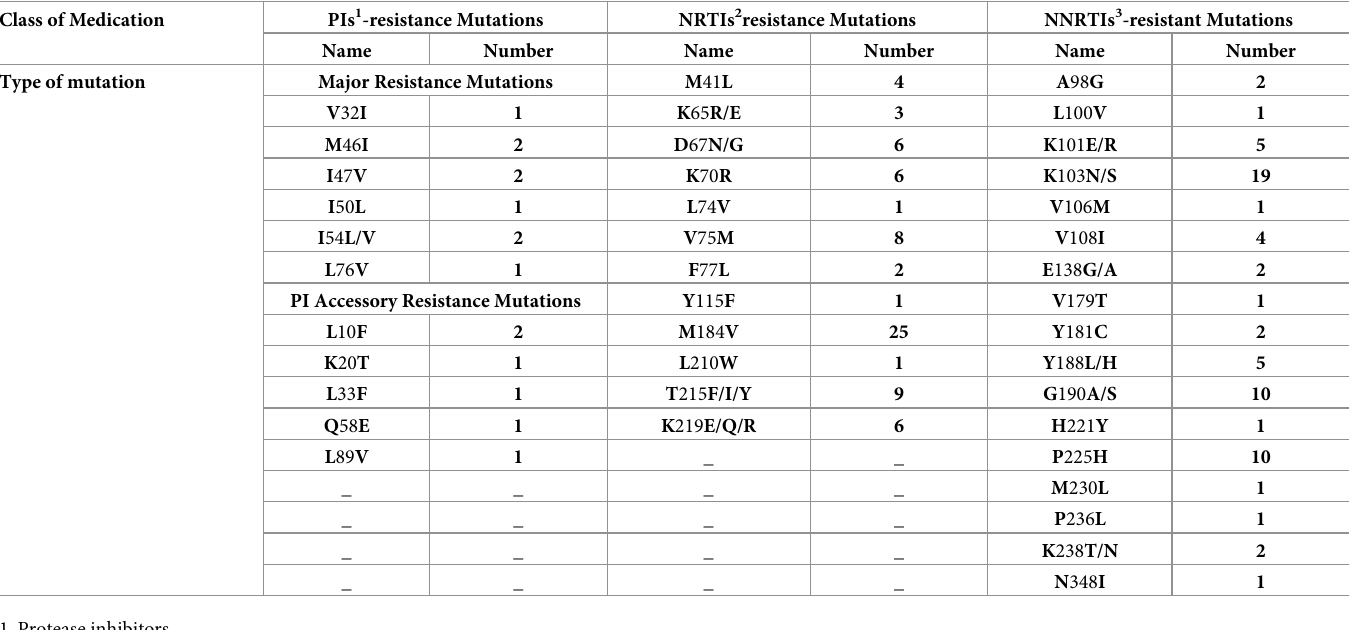
Table 6. Frequency of drug resistance mutations among treatment-failed Iranian patients with HIV, based on WHO List. Class of